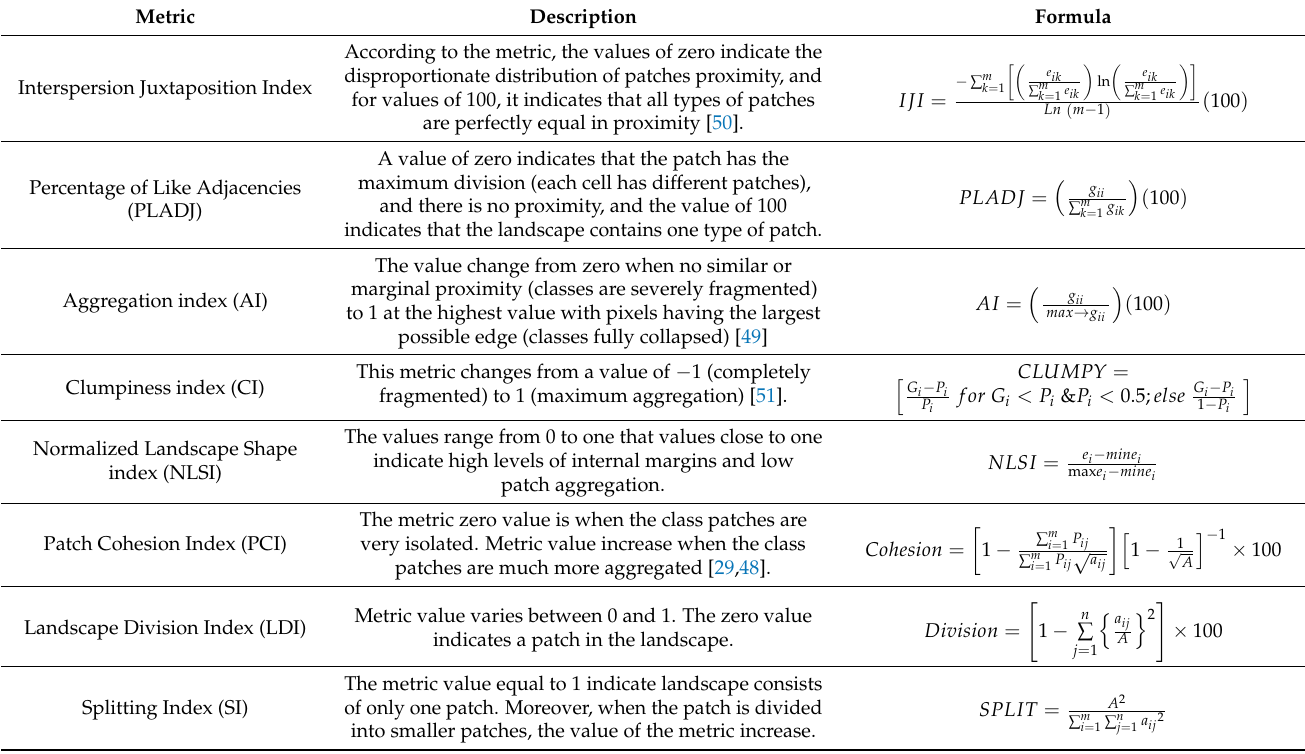
Table 1. Description, ranges, and formulas of the landscape configuration